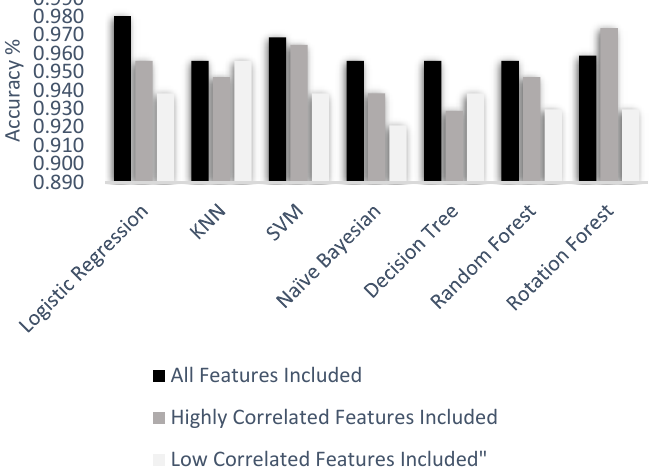
Figure 14. Applied machine learning techniques with accuracy results.